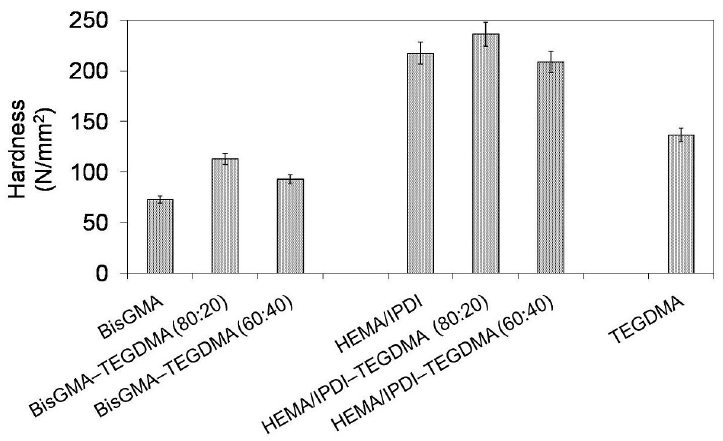
Figure 4. The Brinell hardness of Bis-GMA, HEMA/IPDI and TEGDMA homopolymers